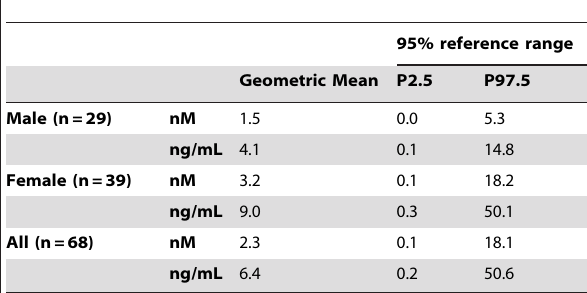
Table 5. Reference values for serum hepcidin (nM and ng/ mL) from non-anemic, iron replete, Kenyan infants without elevated CRP (CRP , 4.1 mg/L AND SF $ 12 ng/mL AND sTfR , 7.4 mg/L AND Hb $ 110